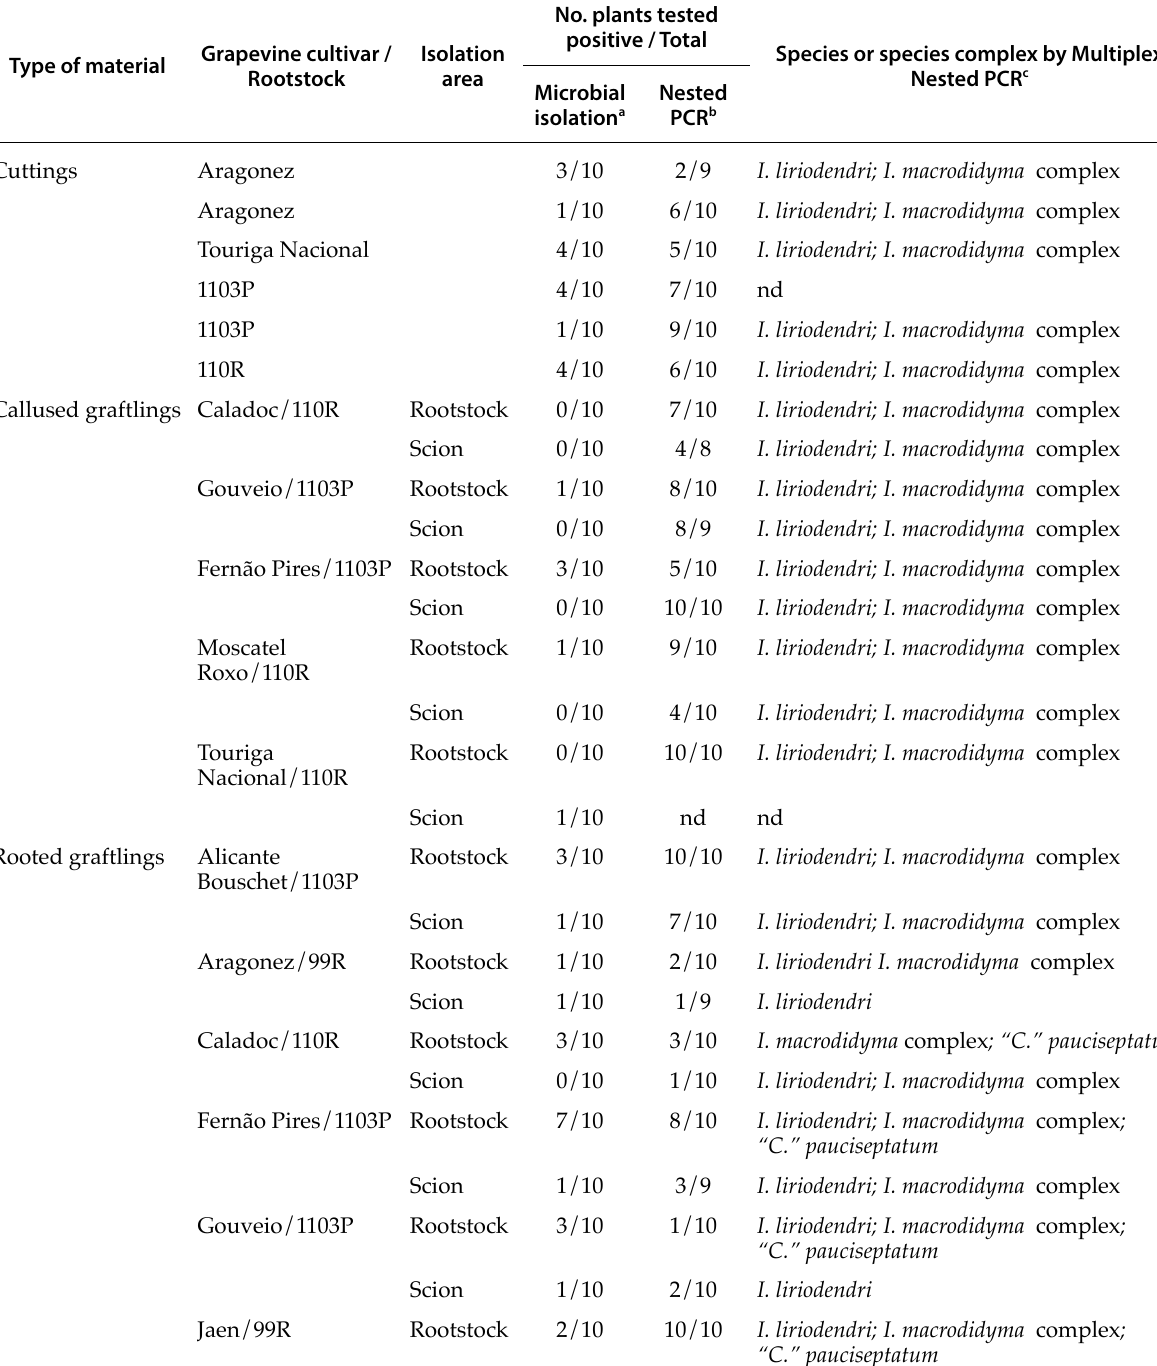
Table 1. Detection of Ilyonectria liriodendri , I. macrodidyma complex and “ Cylindrocarpon ” pauciseptatum in samples from dif- ferent grapevine propagation